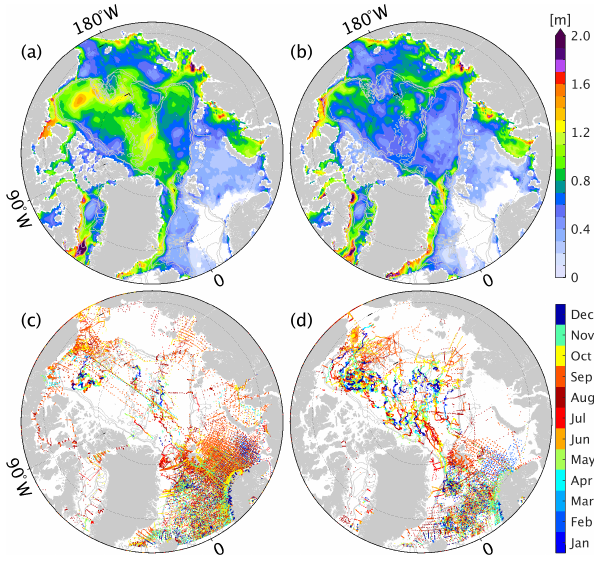
Figure 14. Root mean square errors of freshwater inventory (in me- ter) between the reconstructed state and the “truth” from (a) 1992– 2006 and (b) 2007–2012. Panels (c) and (d) are the corresponding profile locations in different months (color